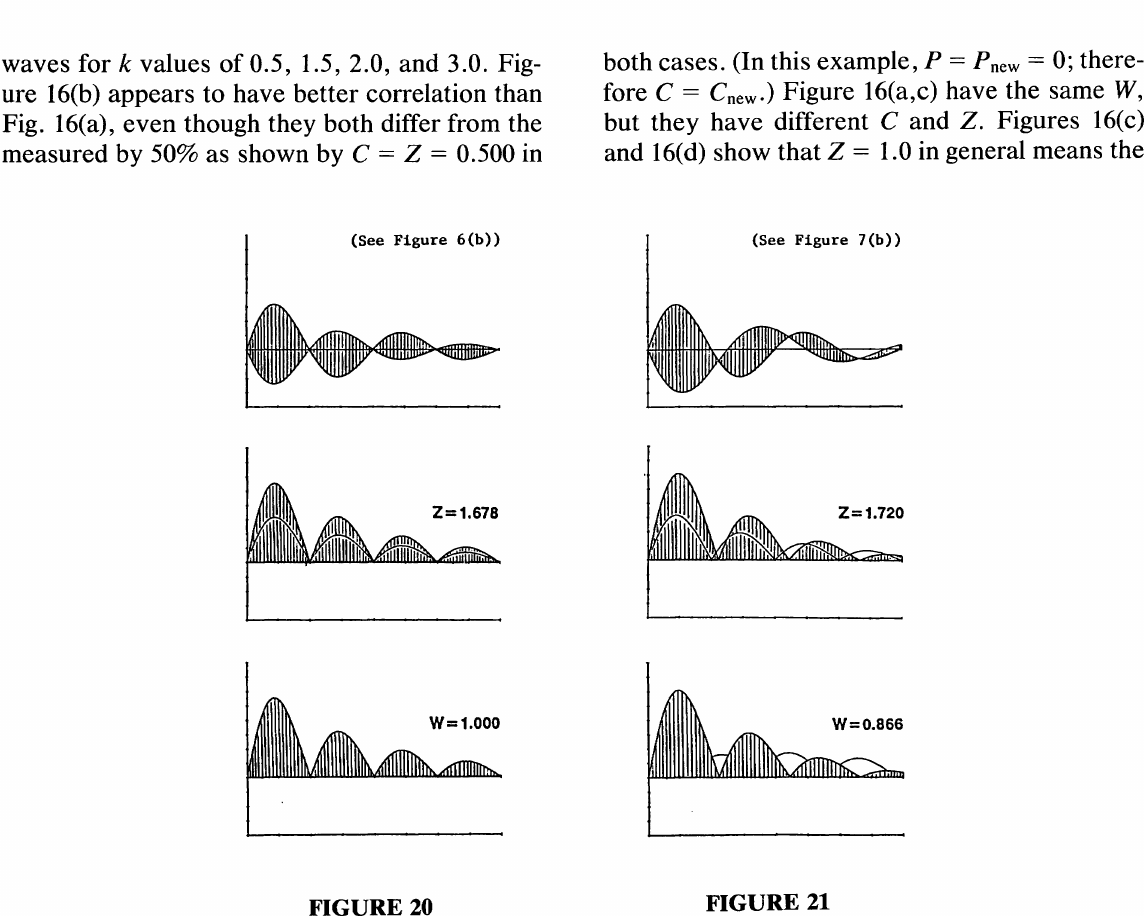
both cases. (In this example, P = P new = 0; there fore C = C new.) Figure 16(a,c) have the same W, but they have different C and Z. Figures 16(c) and 16(d) show that Z = 1.0 in general means